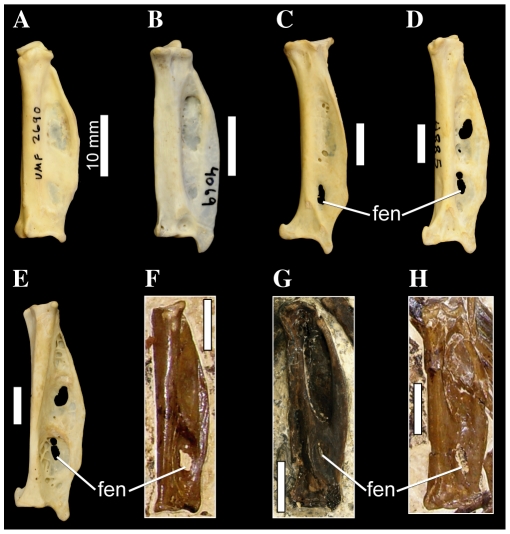
Manual phalanges II-1 of several waterbird taxa.
Ciconia abdimii FMNH 368771 (A), Sula sula FMNH 339372 (B), Fregata minor FMNH 339421 (C), Fregata magnificens FMNH 339418 (D), Limnofregata azygosternon FMNH PA 731 (G), and Limnofregata azygosternon USNM 22753 (H), in ventral aspect; and left phalanges II-1 of Fregata magnificens FMNH 339418 (right element reversed) (E), and Limnofregata azygosternon USNM 22753 (F), in dorsal aspect. Scale bars equal 10 mm. Abbreviations: fen, fenestra.